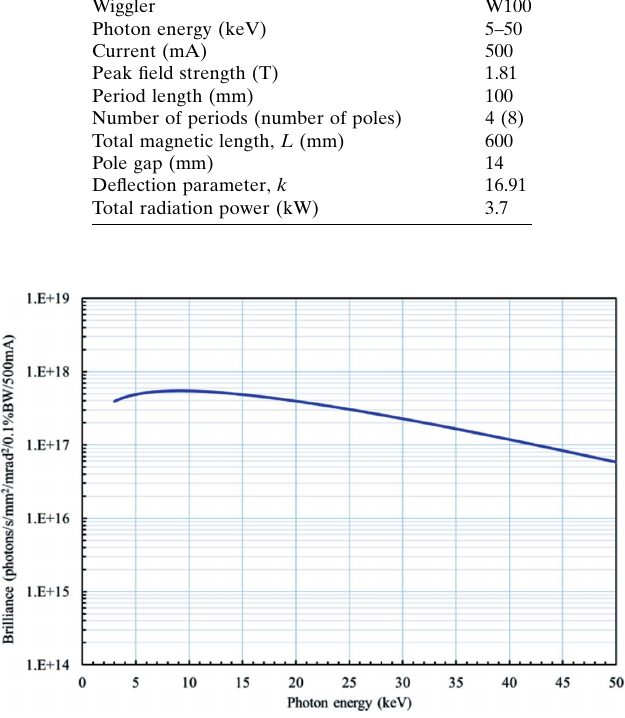
Figure 1 Brilliance of the TPS 31A wiggler, W100.